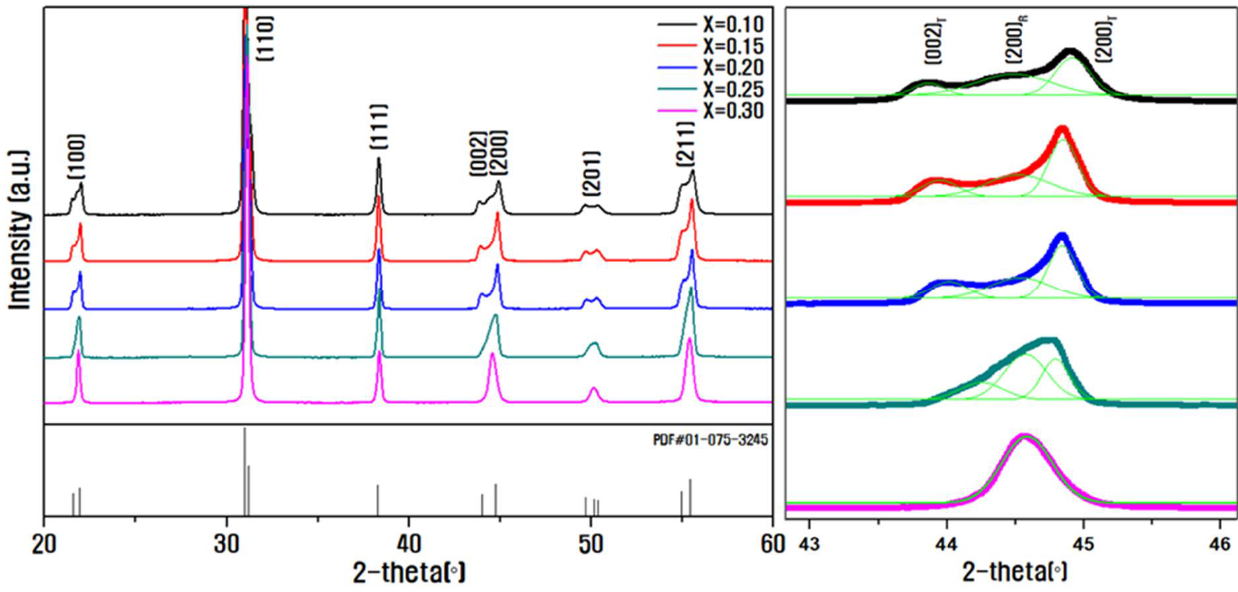
(cid:0) ( (cid:1) Zn 0.8 Ni 0.2 ) Nb 2/3 O 3 − ( 1 − x ) Pb ( Zr 0.5 Ti 0.5 ) O 3 ceramics with vary- 1/3